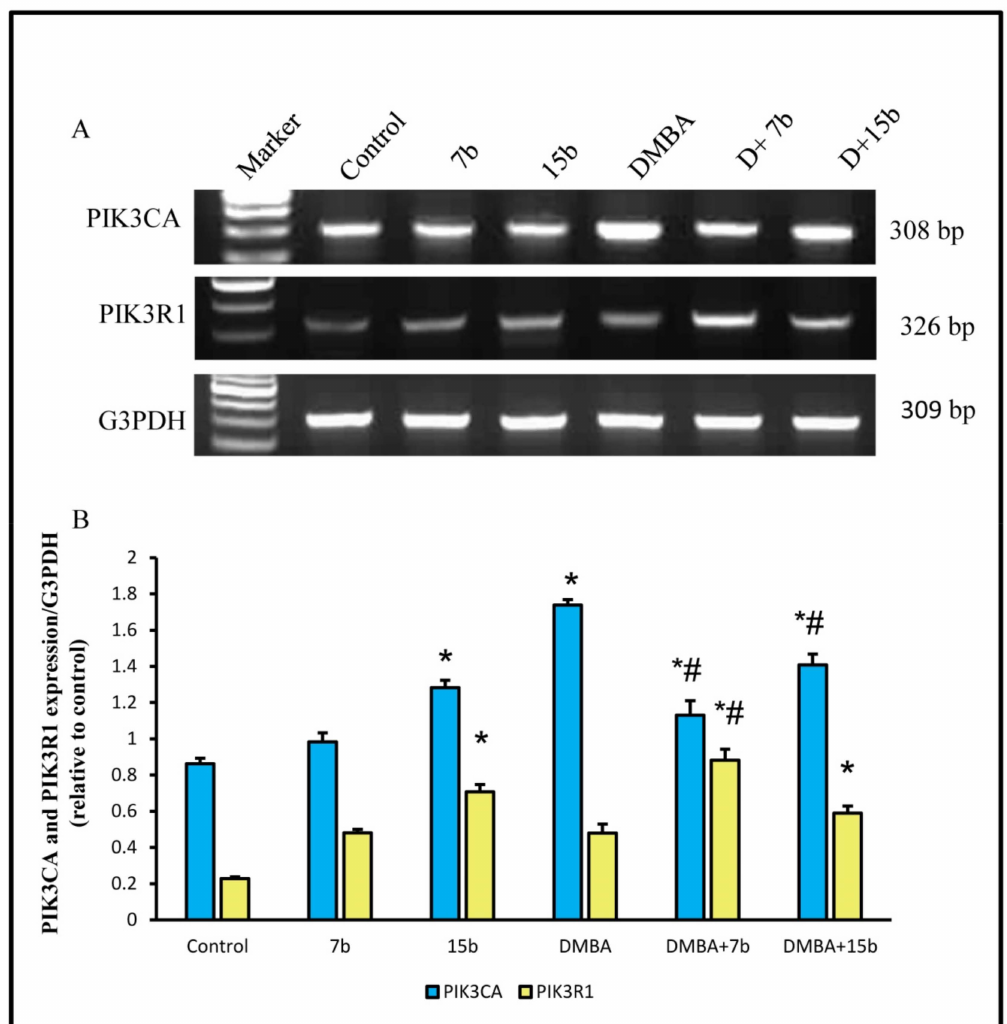
Figure 3. Effect of 7b and 15b compounds on changes in gene expression induced by DMBA in breast. Values are means ± SE of 10 rats. * p < 0.05 vs. control group; # p < 0.05 vs. DMBA group. ( A ) Upper panels are mRNA expression of examined gene. ( B ) Lower columns are densitometric analysis of gene